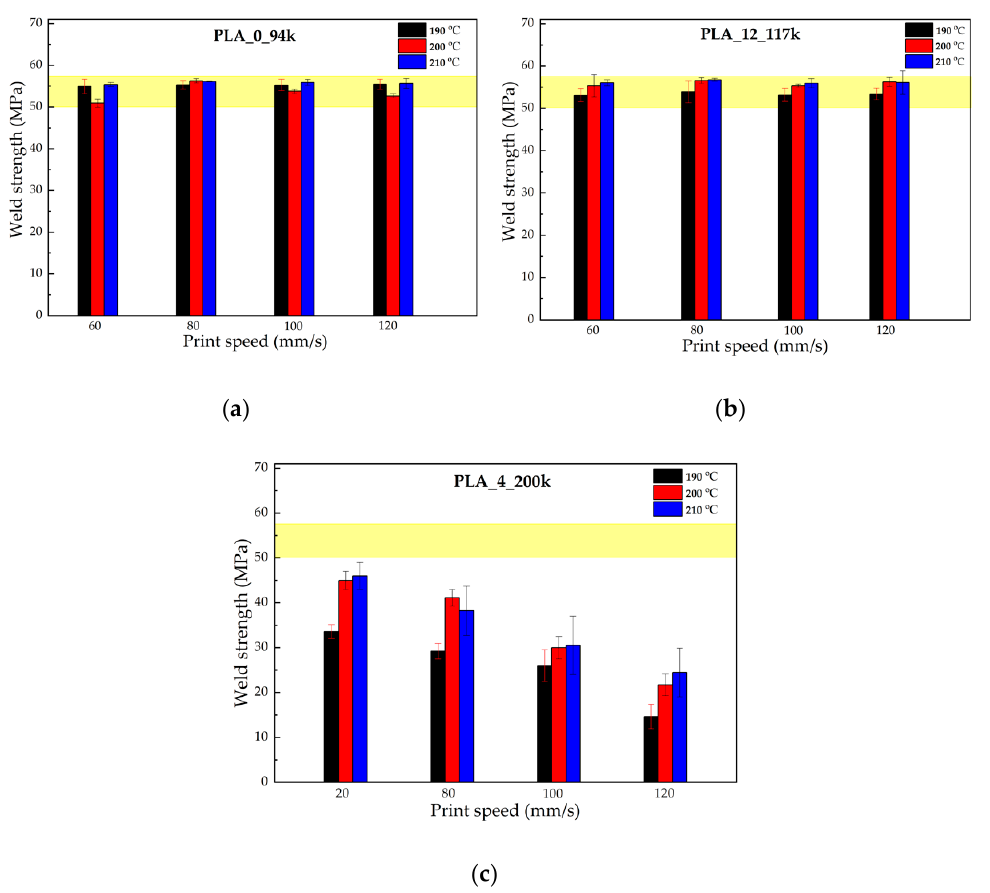
Figure 4. Weld strengths as a function of printing conditions for ( a ) PLA_0_94k, ( b ) PLA_12_117k, and ( c ) PLA_4_200k. The shaded area in each graph corresponds to the range of bulk strength values measured using dog-bone-shaped specimens obtained by compression molding.